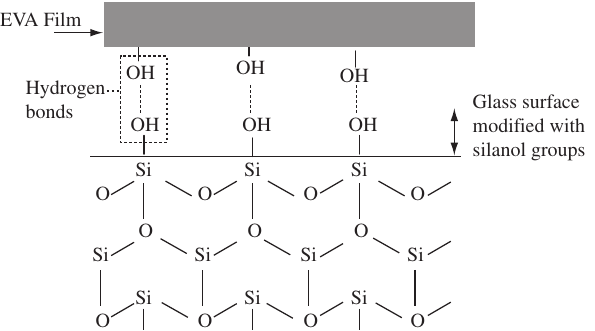
Figure 8. Hydrogen bonds between EVA and surface modified tile with silanol groups.